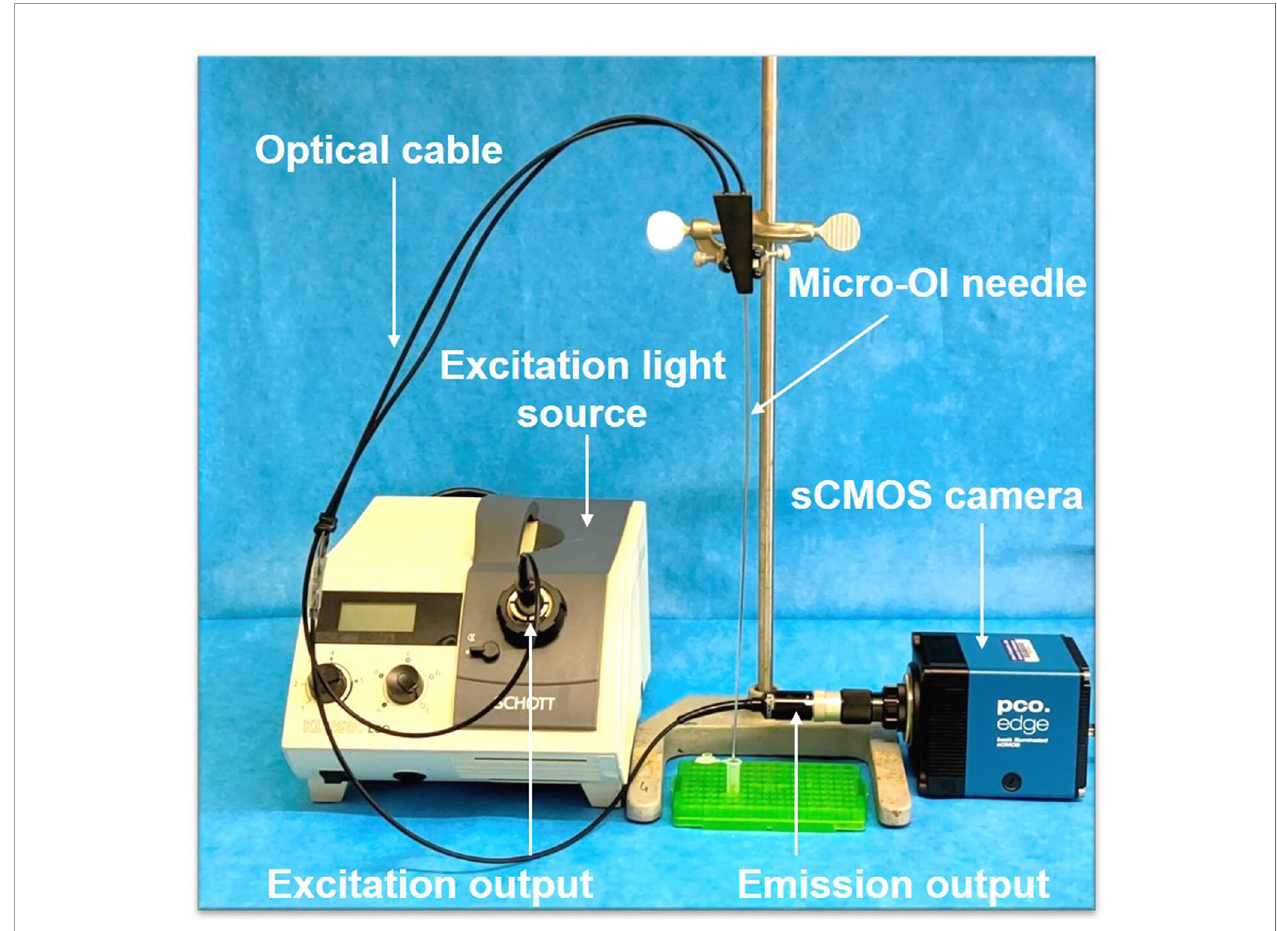
FIGURE 1 | The interventional optical imaging (OI) system. The interventional OI system is constructed with a micro-OI needle and a sCMOS camera that is connected to an excitation light source and a personal computer via its emission